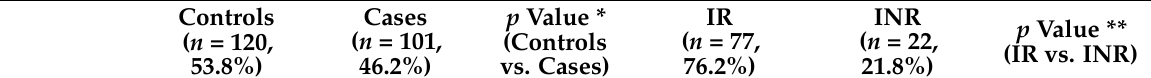
Table 1. Study cohort baseline characteristics in ART-naïve PLHIV according to baseline CD4 + T cell counts (controls vs. cases) and CD4 + T cell counts at 144 weeks of ART (IR vs.